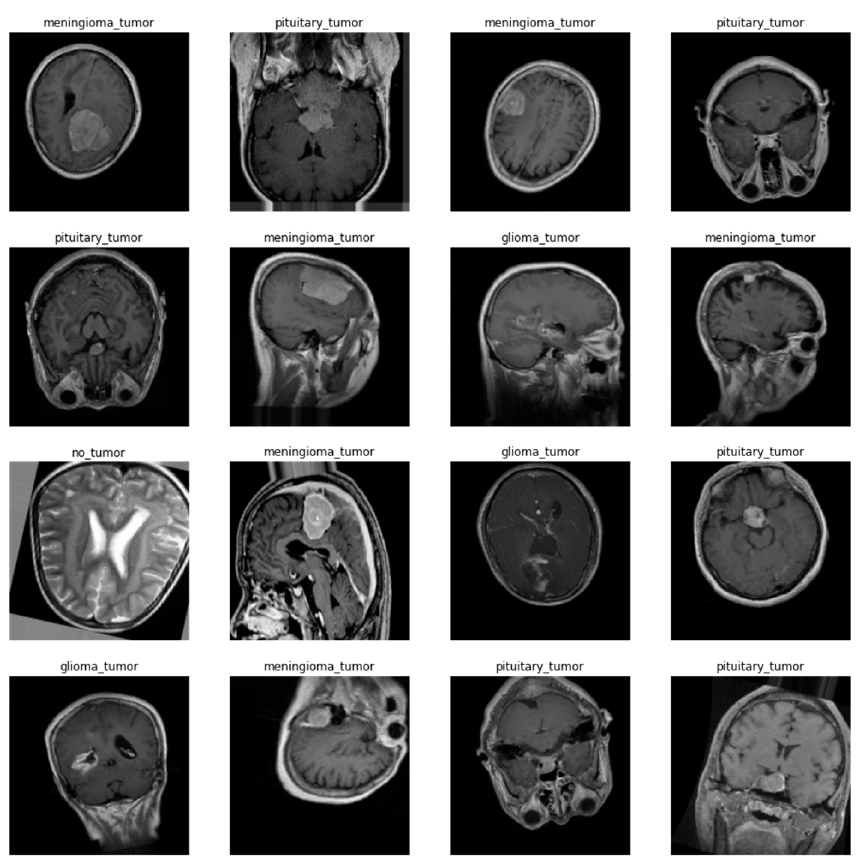
Figure 5. Samples from the training dataset with annotations. Augmented data.